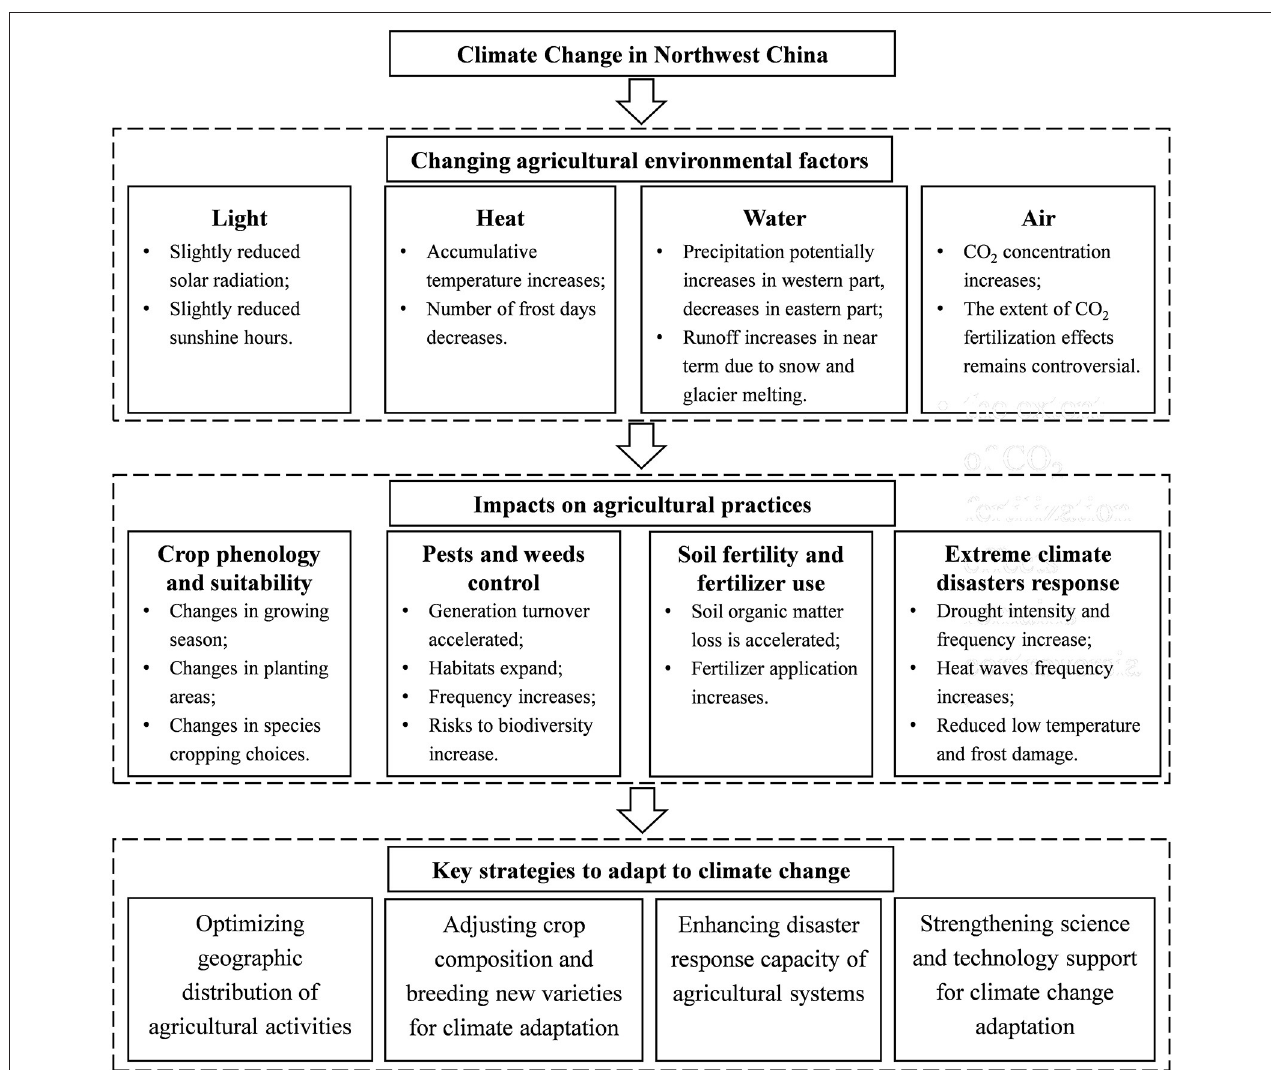
FIGURE 2 | A framework for systematic thinking on sustainable agricultural development in Northwest China in the context of climate change.